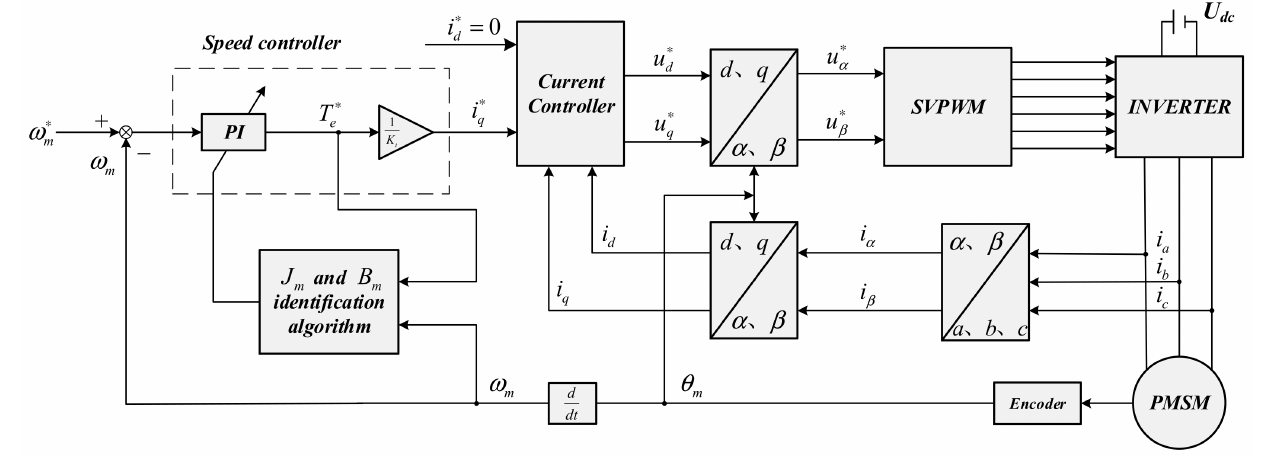
Figure 2. Block diagram of the PMSM drive system parameters